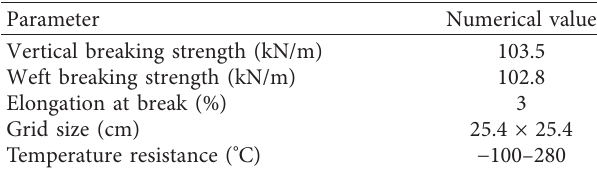
Table 4: Parameters of EGAl00-100 fiberglass geogrid.